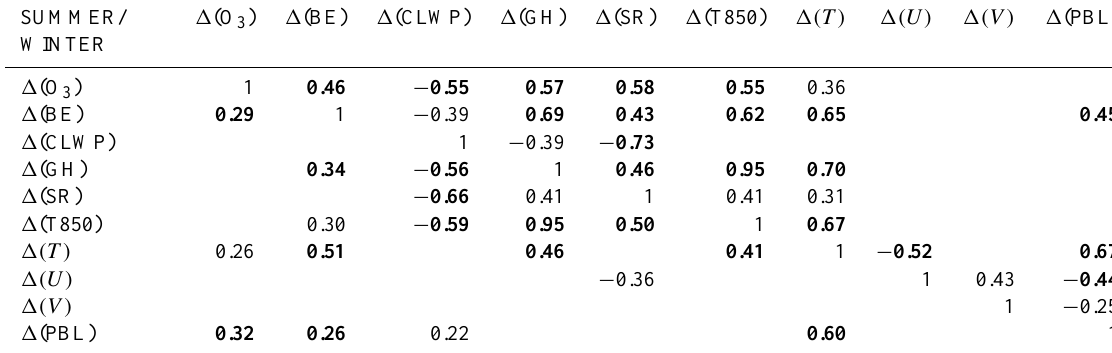
Fig. 2. Average decadal (1991–2000) surface ozone concentrations simulated by the ERA/RegCM3/CAMx modeling system for the winter (left) and the summer (right) season. Table 2. Correlation between differences in selected variables during summer (upper triangular part) and winter (lower triangular part). All correlations are significant at the 95% level of significance. Values in bold are significant at the 99% level of significance.